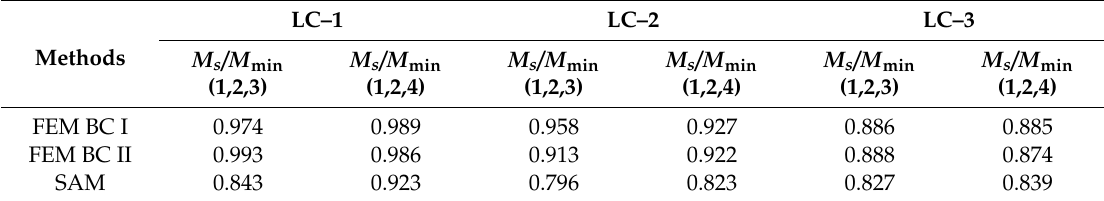
Table 12. Load-carrying capacity for FRP